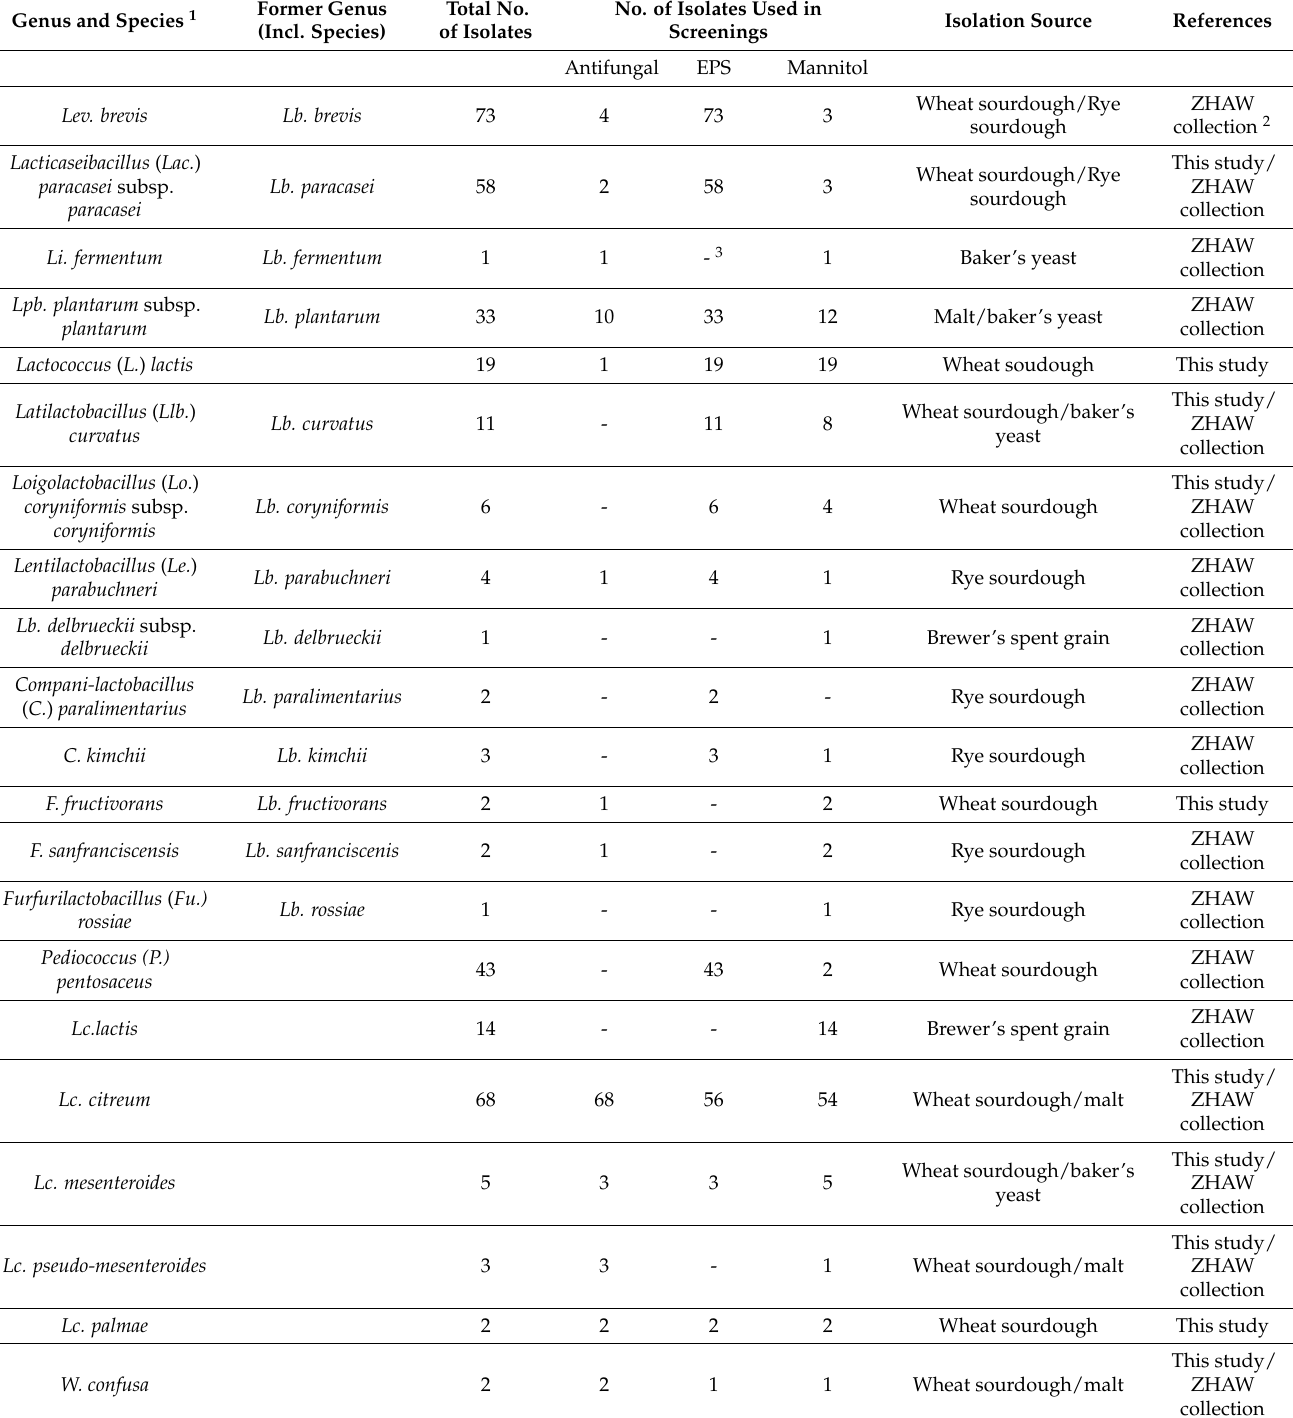
Table 1. Overview of LAB strains used in this